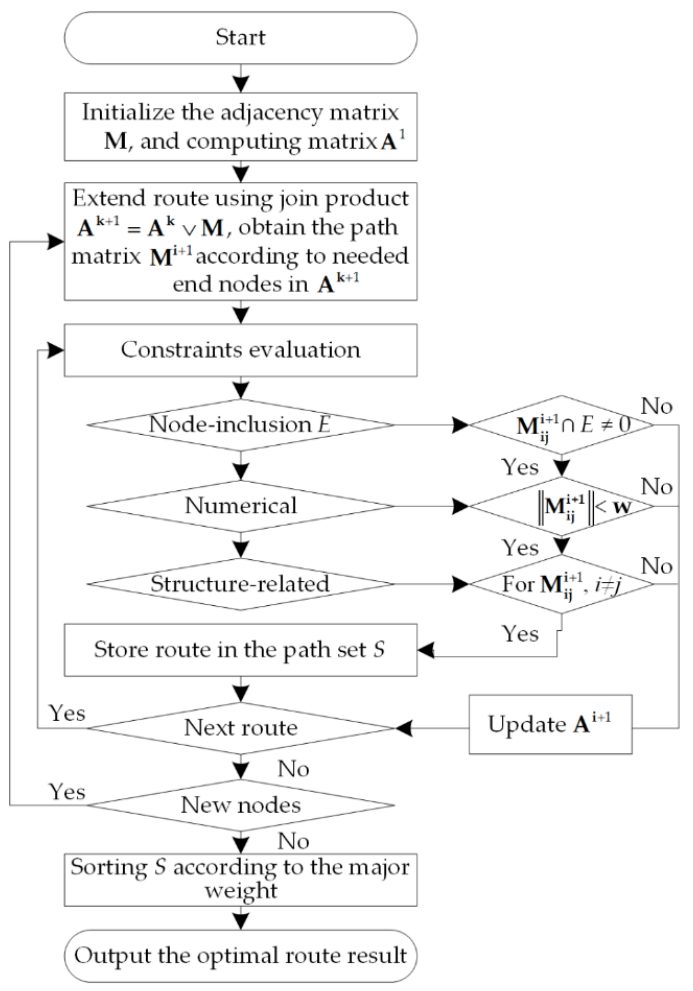
Figure 5. The flow of the multiconstrained optimal path algorithm based on GA.